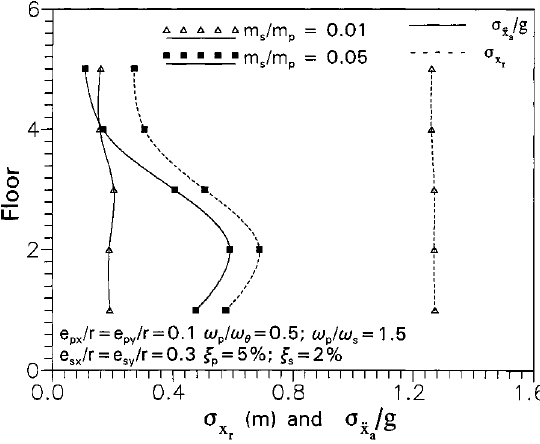
=g with storey height for various values of Fig. 13. Variation of (cid:27) (cid:127) x a e s x =r and e s y =r ; for m s =m p = 0.01; ! p =! s = 1.5; ! p =! (cid:18) = 1.0; e p x =r = e p y =r = 0.1; (cid:24) p = 5% and (cid:24) s = 2%.